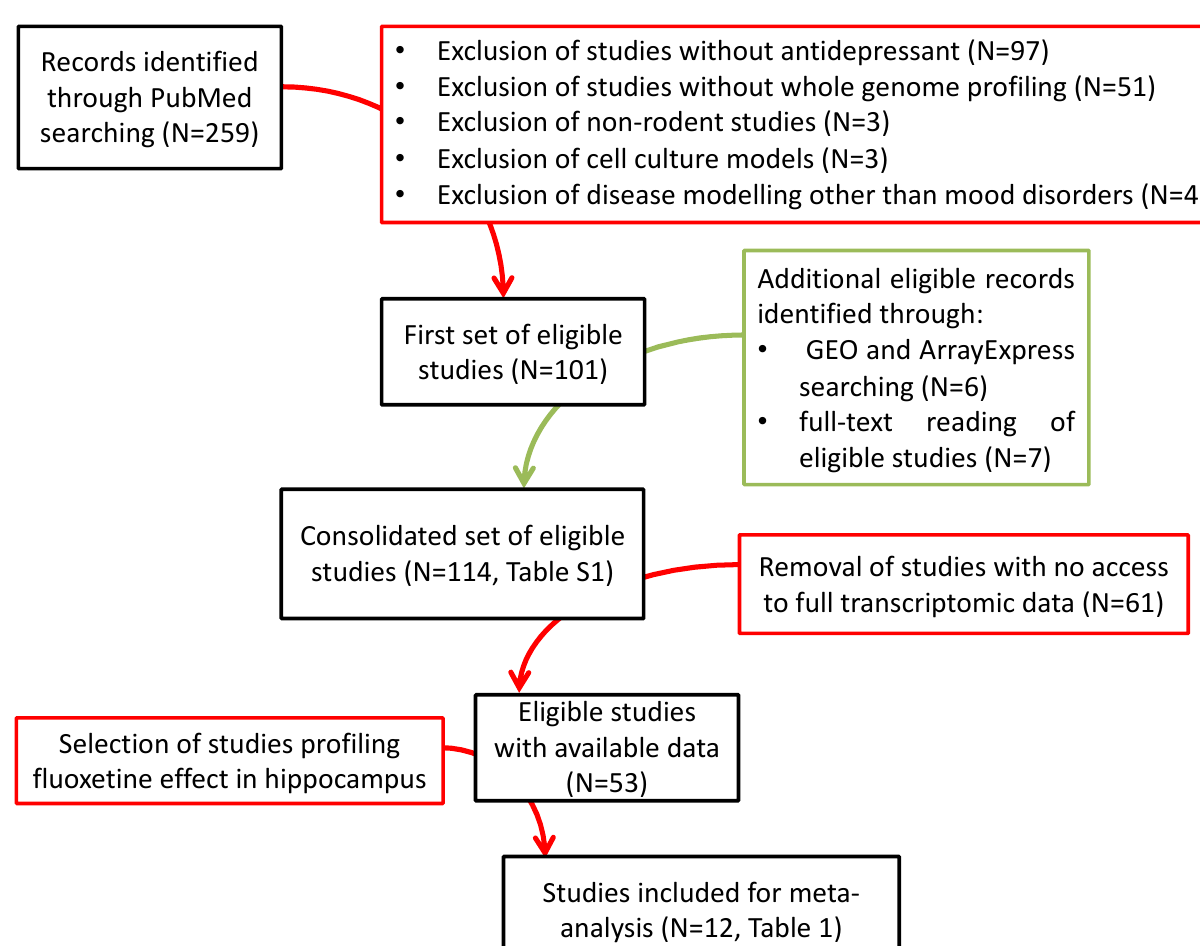
Figure 1. Flow diagram outlining the selection procedure of the studies kept in the meta-analysis.